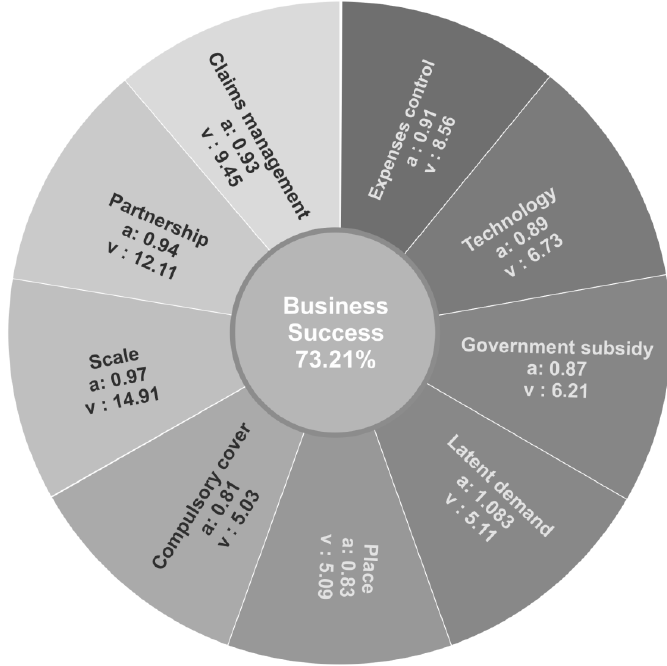
Figure 1. The general model